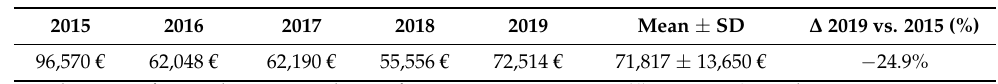
Table 2. Expenditure on